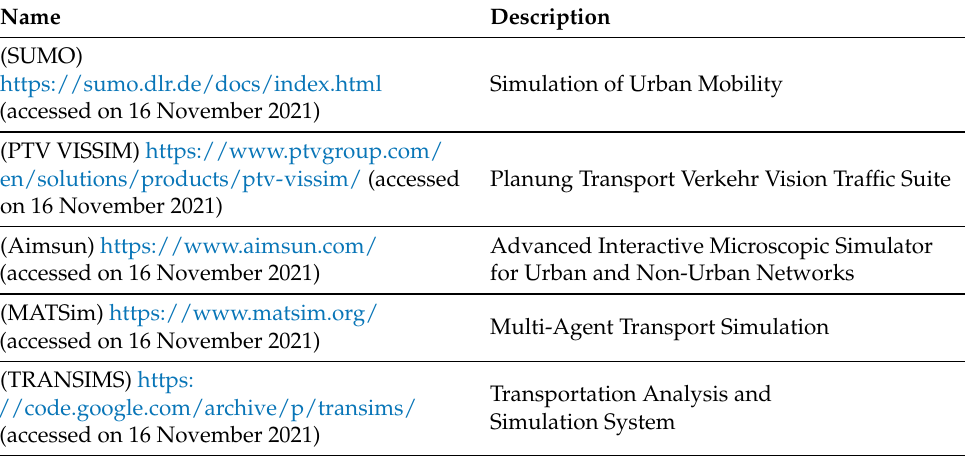
Table 29. Simulation environments found during this